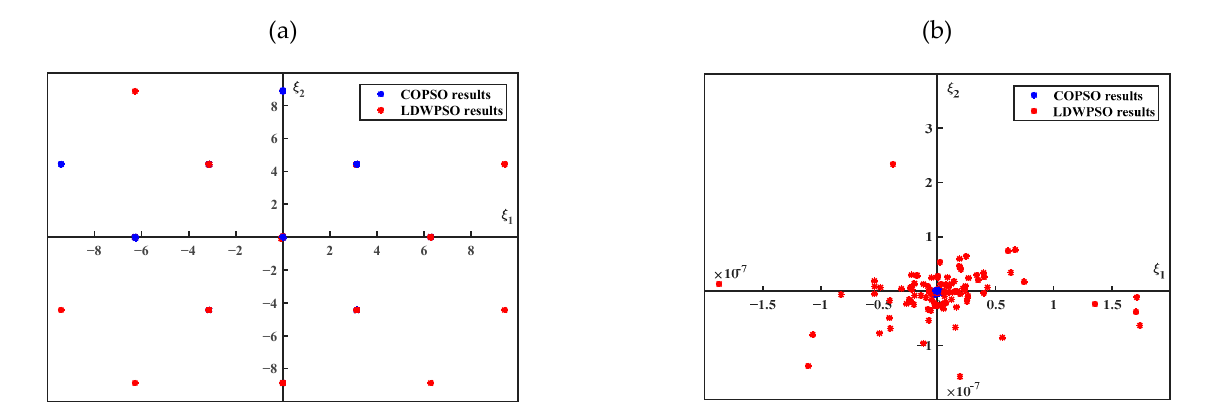
Figure 3. Distribution of the function results: ( a ) Griewank function; ( b ) Ackley function. Table 1. Comparison of different inertia weights for performance indicators. Griewank Function Ackley Function Inertia Weight Mean Value Standard Deviation Mean Value Standard Deviation of Fitness of Fitness of Fitness of Fitness